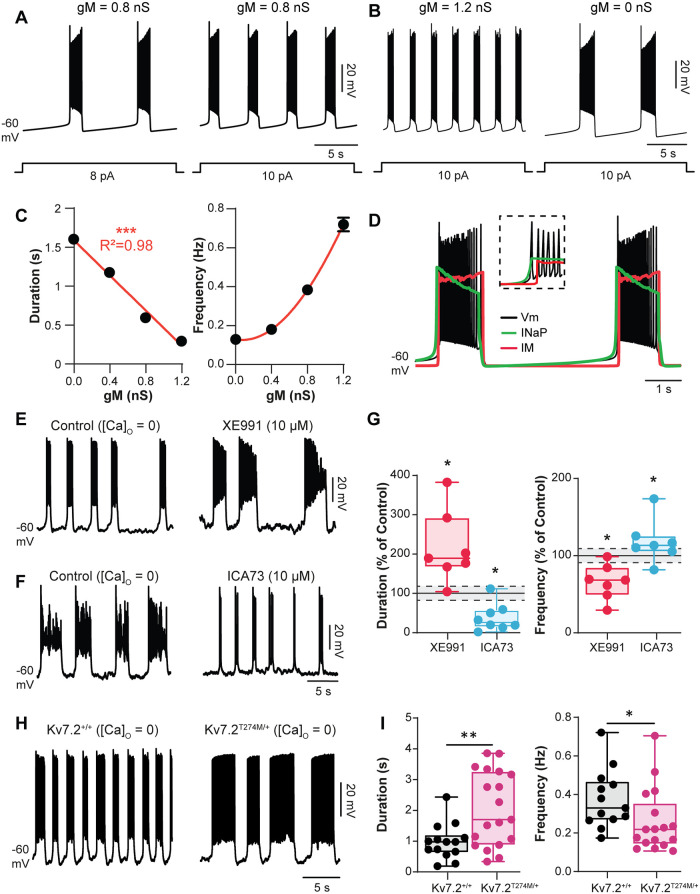
IM controls burst dynamics.(A,B) Firing behavior from a bursting pacemaker neuron model in response to incrementing depolarizing current injections (A) or for 2 different values of gM (B). The injected current pulses are indicated below voltage traces V1/2
INaP = −54 mV. (C) Duration and frequency of bursts as function of gM in the heterogeneous population model of 50 neurons. Results are pooled from 10 simulations. R2 indicates the correlation index. (D) Dynamics of the neuronal membrane potential (black), the INaP (green), and the IM (red) during bursting activity of a single pacemaker neuron model. The broken-line box highlights dynamics of INaP and IM at the onset of bursts. (E,F) [Ca2+]o-free-saline–induced bursting activity recorded intracellularly from L1–L2 ventromedial interneurons before and after XE991 (10 μM, n = 7 cells) (E) or ICA73 (10 μM, n = 7 cells) (F). (G) Normalized changes of burst parameters. Dashed lines with gray shading indicate the 95% confidence intervals of control values. *P < 0.05, comparing data before and after the abovementioned drugs; Wilcoxon paired test. (H) [Ca2+]o-free-saline–induced bursting activity recorded intracellularly in L1–L2 ventromedial interneurons from wild-type (n = 13 cells) and Kv7.2Thr274Met/+ mutant mice (n = 18 cells). (I) Boxplot quantification of burst parameters. *P < 0.05, comparing wild-type versus mutant; Mann–Whitney test. Underlying numerical values can be found in the S1 Data. ICA73, N-(2-chloro-5-pyrimidinyl)-3,4-diflurobenzamide; XE991, 10,10-bis(4-pyridinylmethyl)-9(10H)-anthracenone dihydrochloride.